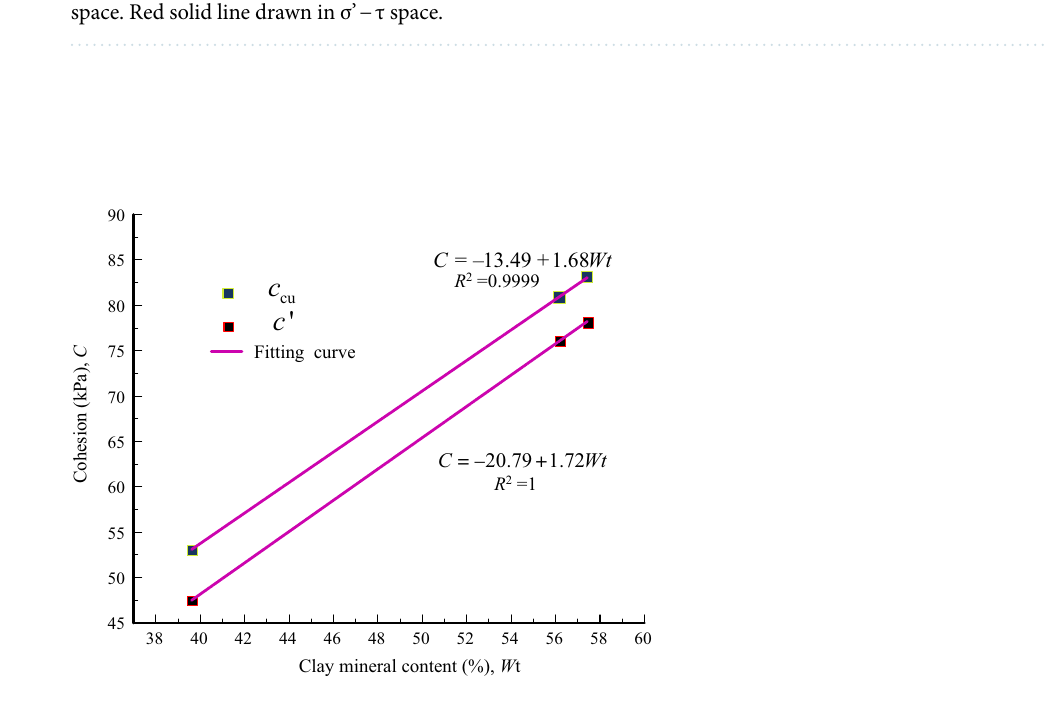
Figure 12. Relationship between cohesion and clay mineral